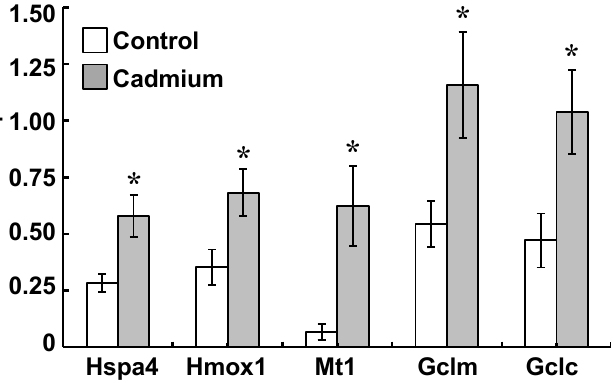
Figure 4. Gene expression for rat heat shock protein-70 (Hspa4), heme oxygenase (Hmox1), metal- lothionein (Mt1), GCLM (Gclm), and GCLC (Gclc) in isolated neonatal rat lateral and fourth choroid plexus (CP) tissues exposed in vitro to cadmium. Lateral and fourth CP tissues from four neonatal rats were harvested and pooled; this comprised a single sample (i.e., n = 1). Each set of tissues was incubated in serum-free medium (SFM) with 0 or 500 nM CdCl 2 for 24 h (37 °C). The mRNA was analyzed in triplicate by qualitative RT-PCR in six separate sets of CP tissues. The mRNA expression for each test gene was normalized to mRNA for rat β -actin (Actb) and GAPDH (Gapdh). Values are